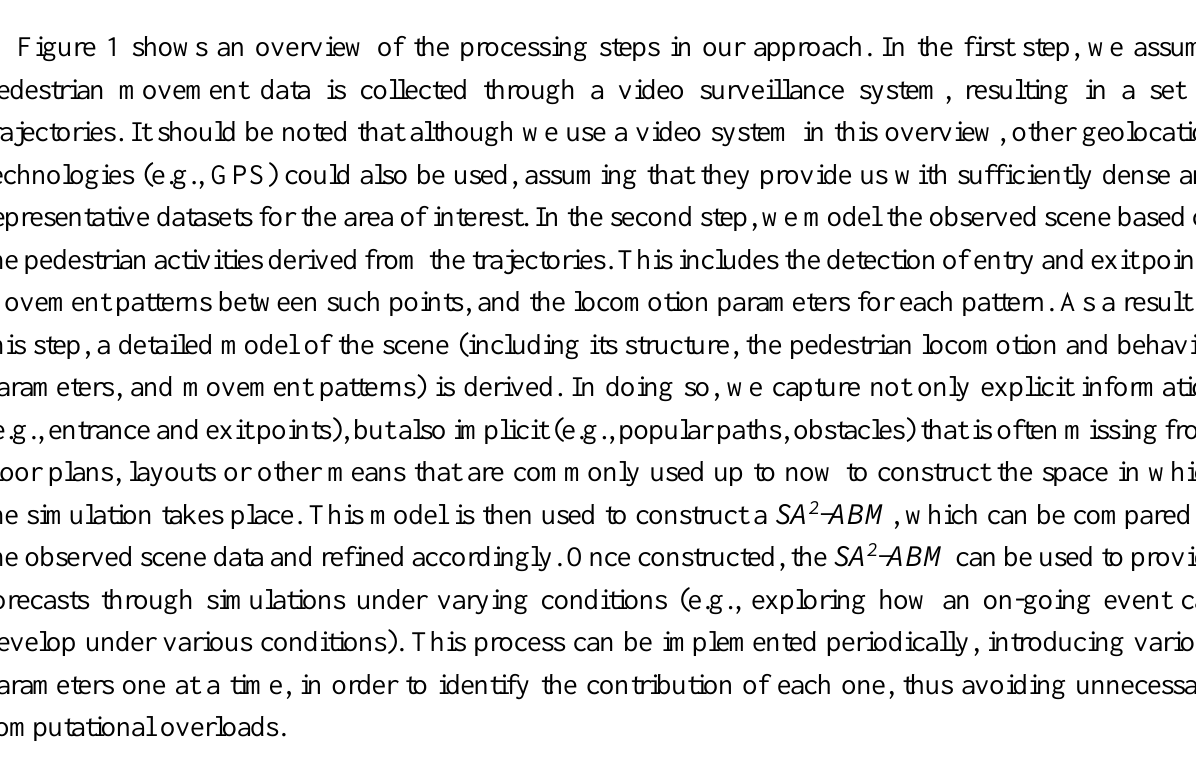
Figure 1. Approach